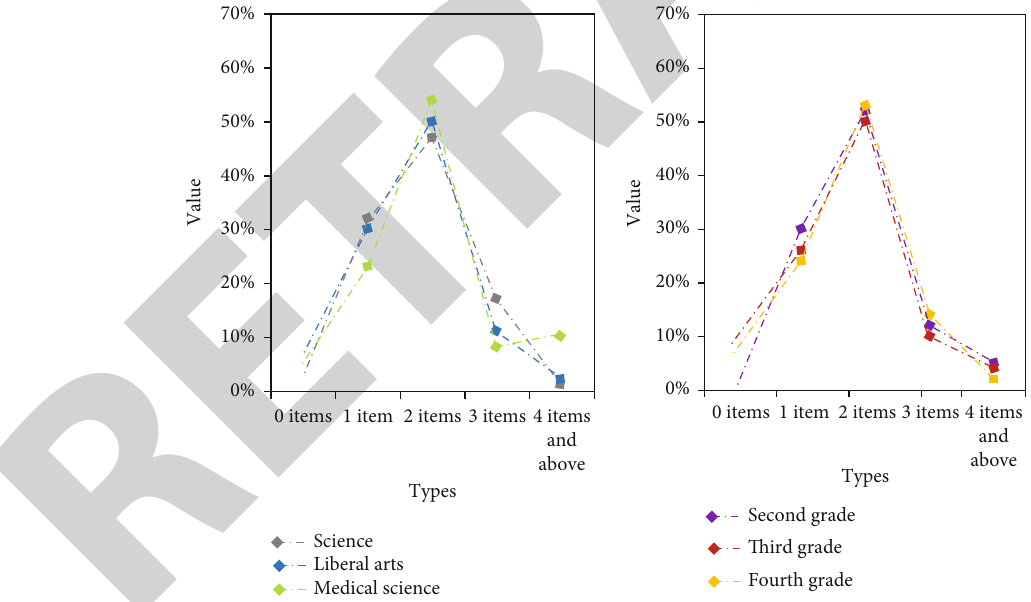
Figure 9: The situation of exercise items for college students in di ff erent disciplines and di ff erent